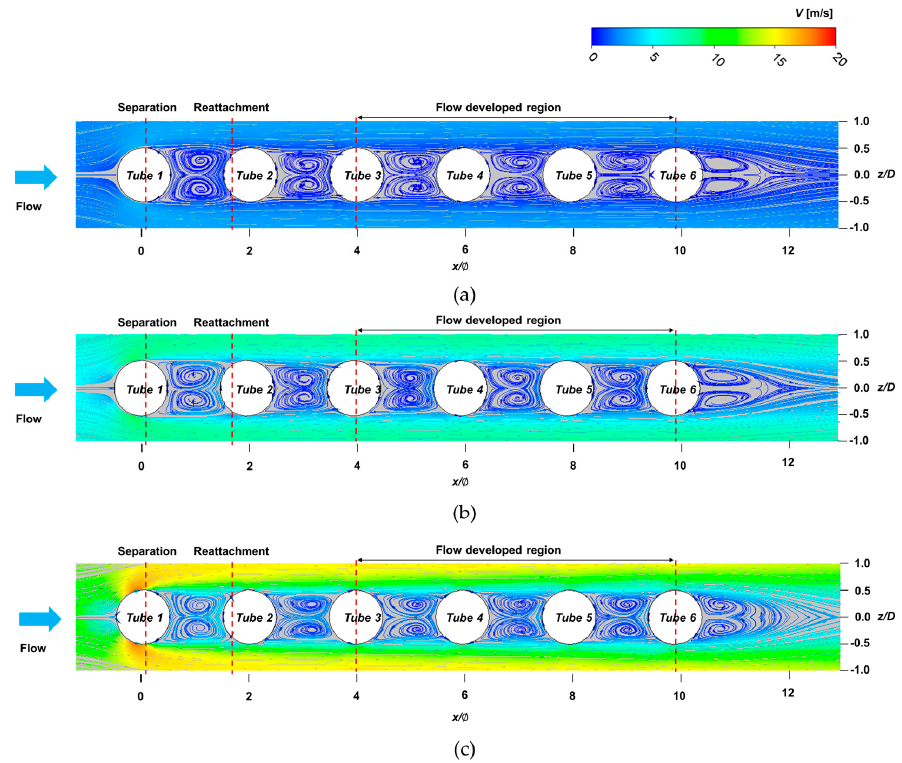
Figure 4. Flow at middle row of tube bundles: ( a ) Re = 5000; ( b ) Re = 15,000; ( c ) Re = 30,000.